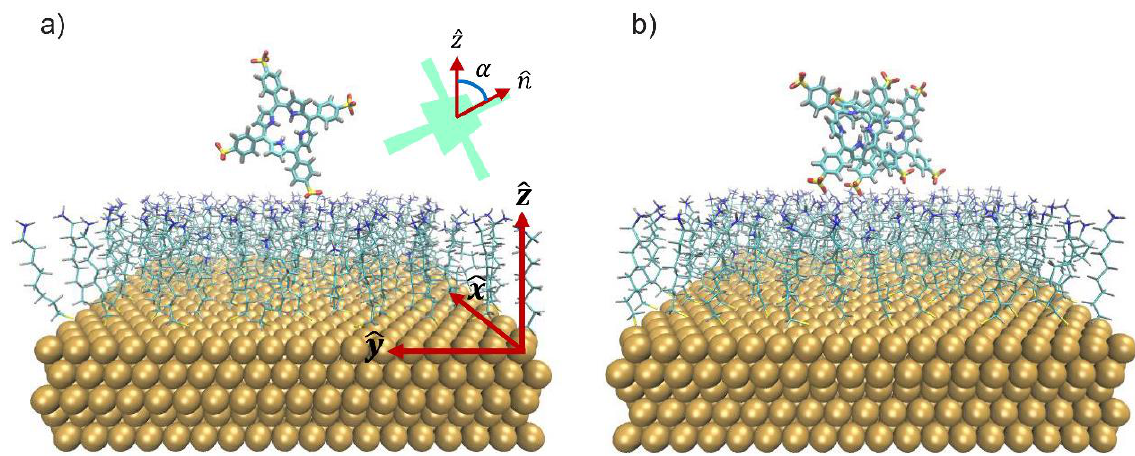
Figure 5. The central structures of the most representative clusters (33.2% and 82.7% of the analyzed frames, respectively). They were obtained from the one- µ s simulations, starting from a ‘parallel’ porphyrin ( a ) and the ‘hydrophobic’ dimer ( b ). As in the following, water, and Cl − counterions are not shown for clarity. The inset shows, schematically, how the angle, α , between the normal vector to the porphyrin plane and the Z -axis was defined.